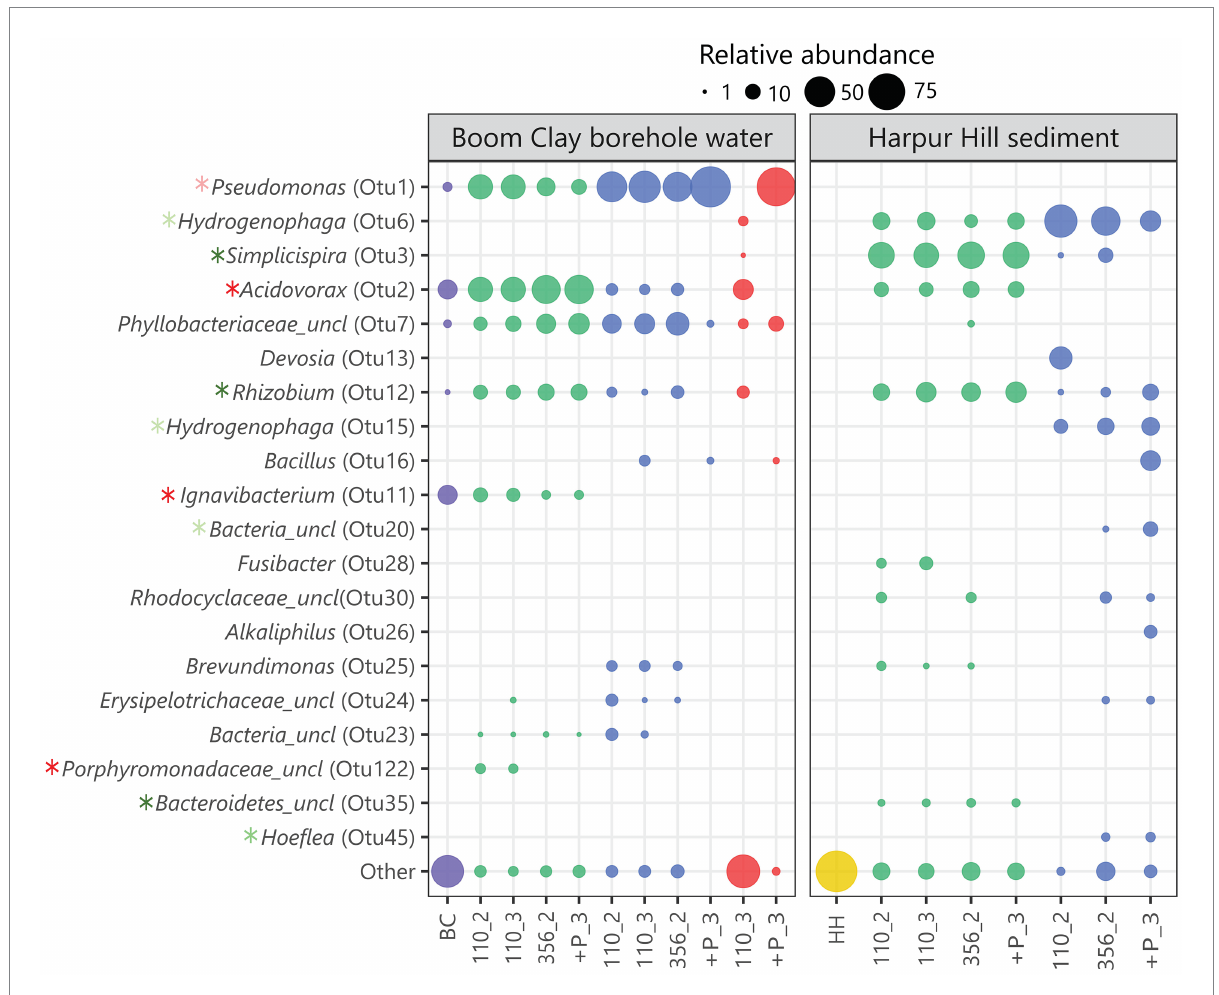
FIGURE 8 Bubble plot showing the relative abundance of the 20 most varying OTUs. The initial Boom Clay borehole water community is represented in purple, the Harpur Hill sediment is shown in yellow, conditions with initial pH 9 are indicated in green, with initial pH 10.5 in blue and with initial pH 12.5 are shown in red. OTUs significantly associated with Boom Clay borehole water at initial pH 9 or pH 10.5 are indicated with a dark red and light red asterisk, respectively. OTUs significantly associated with Harpur Hill sediment at initial pH 9 or 10.5 are indicated with a dark green and light green asterisk, respectively. Sample names are encoded as day_replicate; + P indicates phosphate